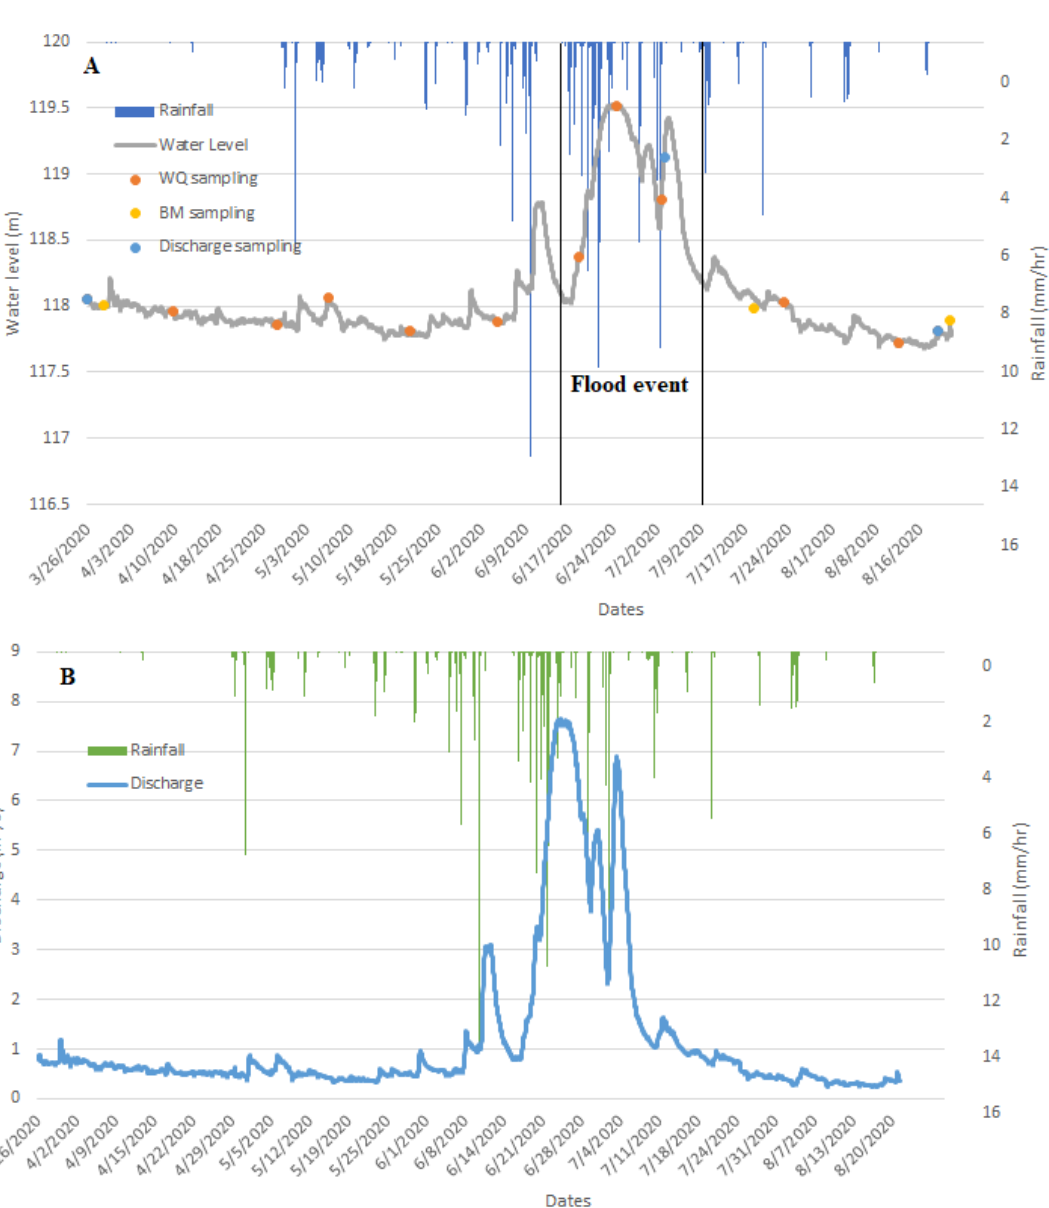
Figure 3. ( A ) Comparison of rainfall and water level from March to August 2020 at site M8 highlighting the start and end of the flood event as well as the sampling dates for water quality and macroinvertebrates. ( B ) Time series of daily discharge and rainfall at site M8 from March to August 2020.